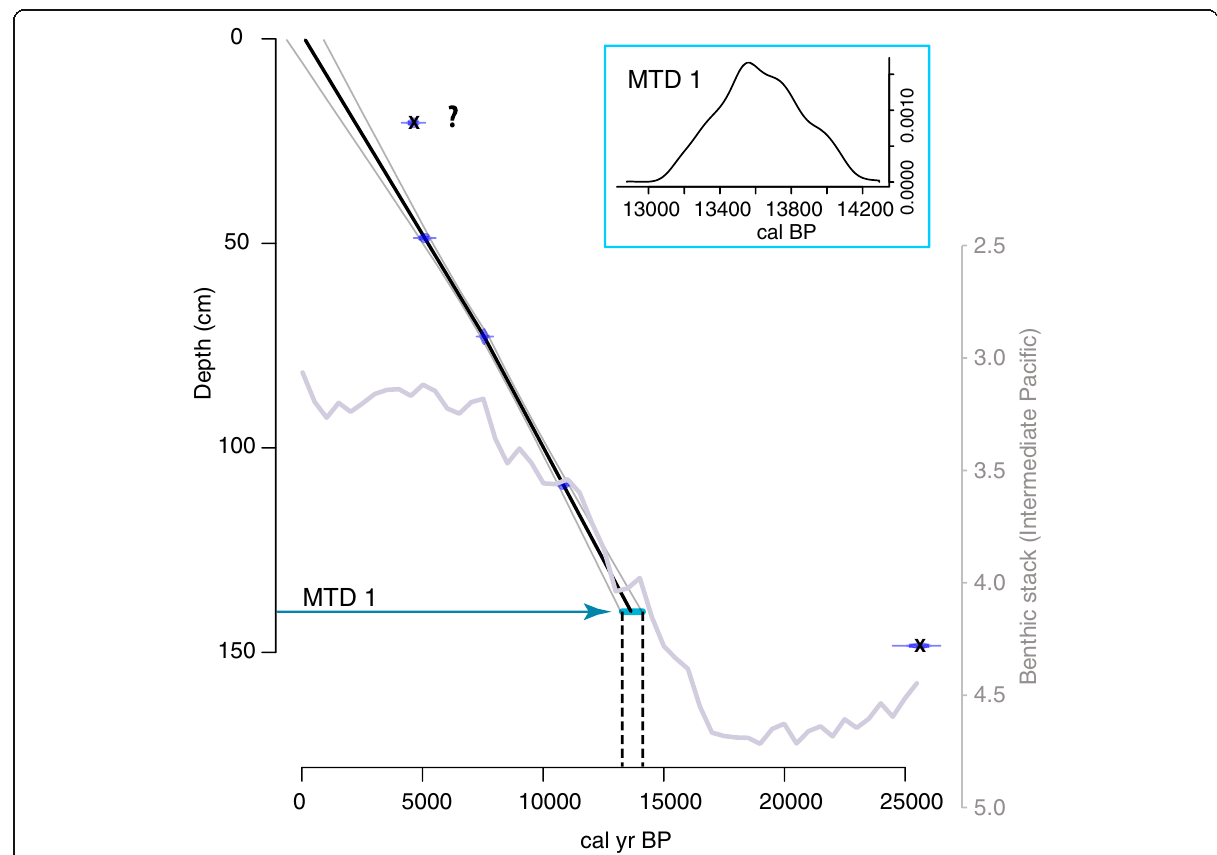
Fig. 5 Age model of MTD 1. Calibrated age intervals are indicated with 95% probability (Table 1). The gray envelope shows the 95% confidence interval, giving an extrapolated age of 13,000 – 14,200 year cal BP for MTD 1. The inset represents the age probability of MTD 1. The gray curve refers to the δ 18 O values of benthic foraminifera of the stacked curve, representative of the intermediate Pacific (Stern and Lisiecki